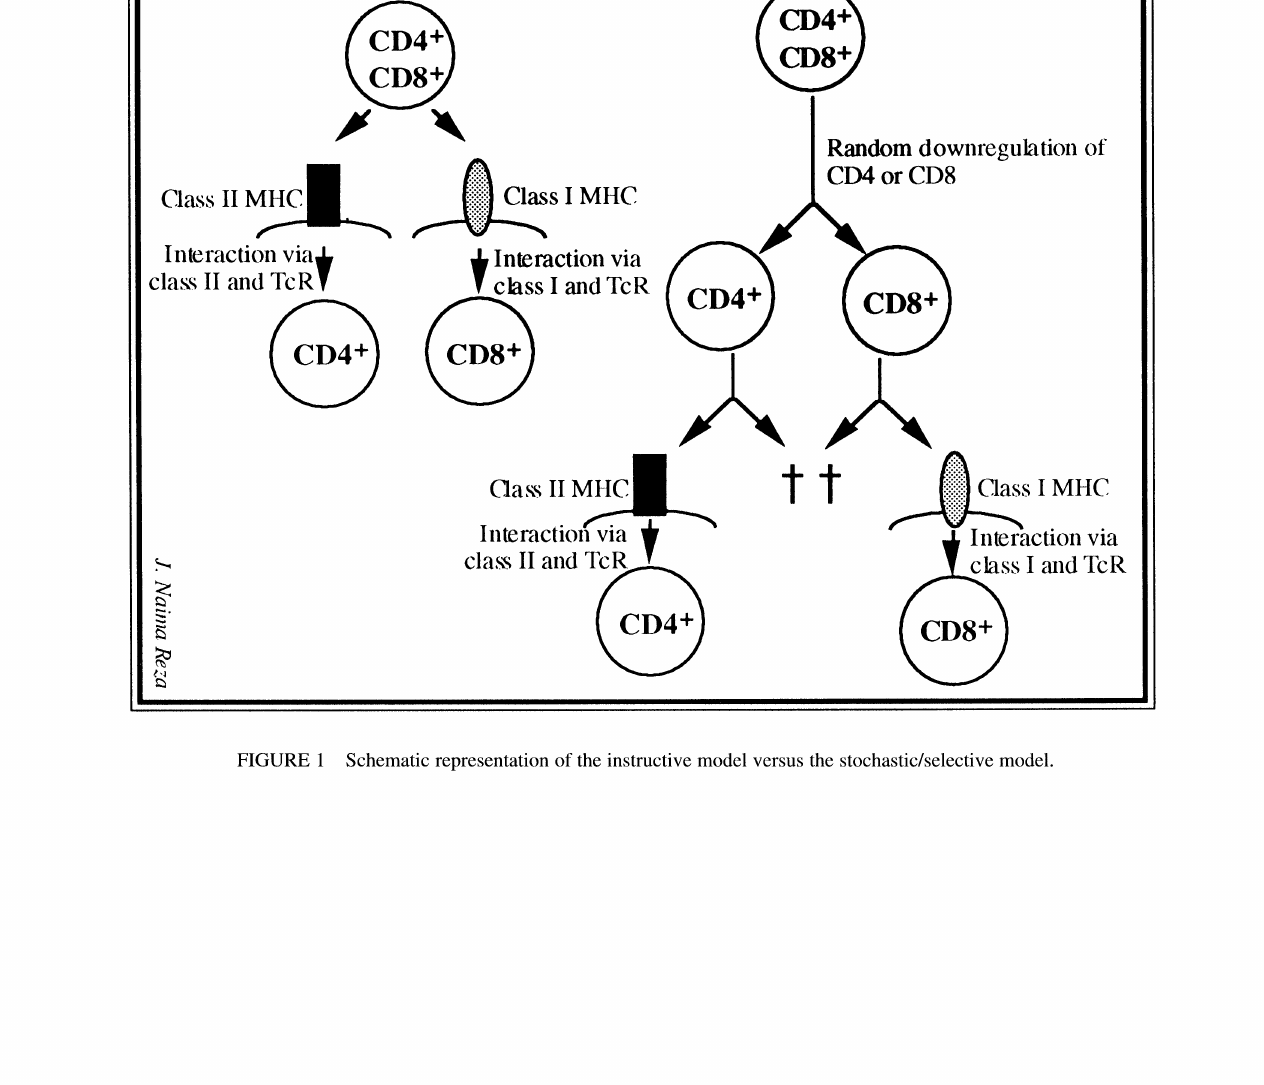
FIGURE Schematic representation of the instructive model versus the stochastic/selective